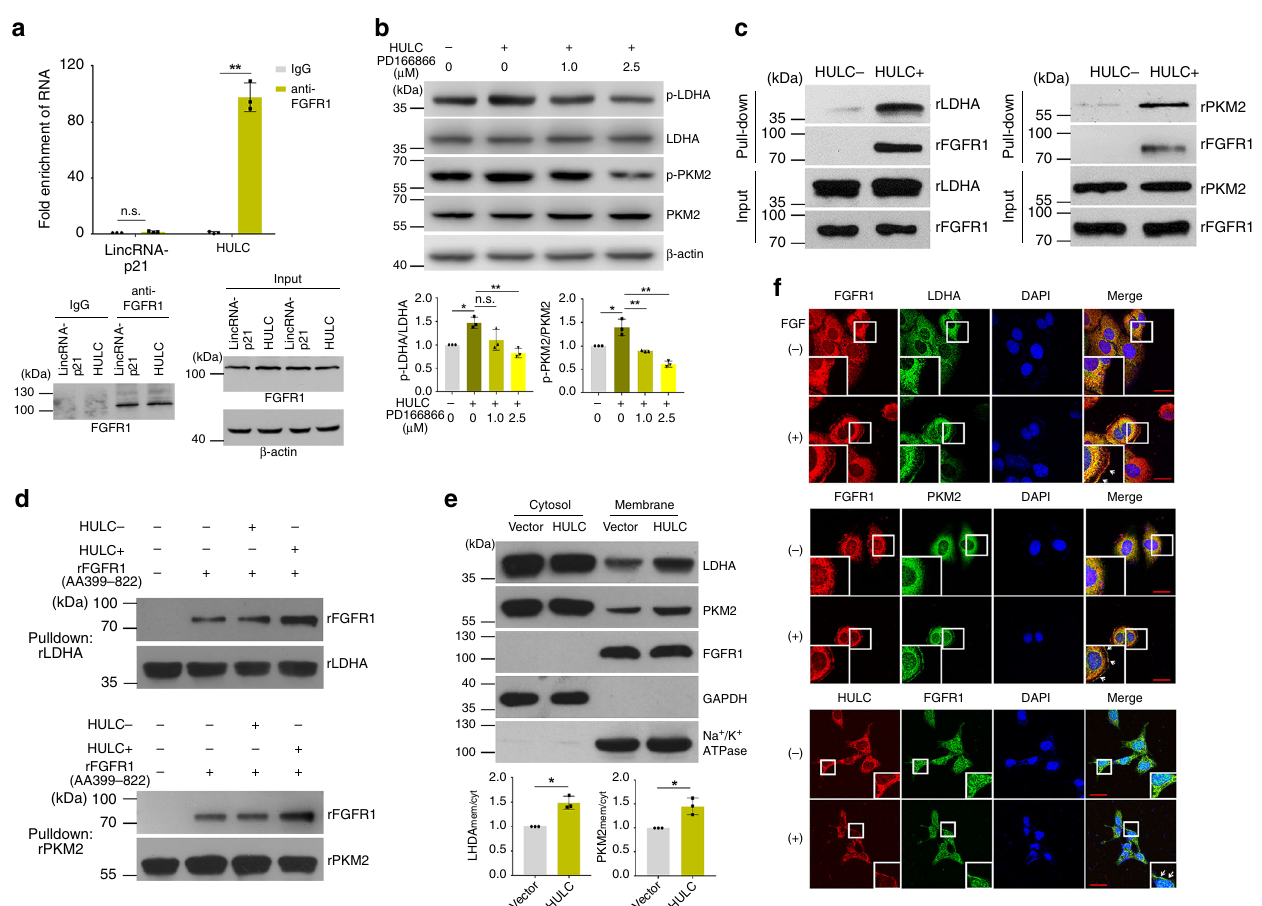
Fig. 5 HULC modulates the phosphorylation of LDHA and PKM2 through FGFR1. a qRT-PCR analysis of the enrichment of HULC in FGFR1 immunoprecipitates. LincRNA-p21 was used as the RNA control. Data represent mean ± s.d. of triplicate independent analyses (*** P < 0.001, n.s., not signi fi cant, by two-sided Student ’ s t test). Immunoblots of FGFR1 in the cell lysates and immunoprecipitates are shown in the lower panel. b Immunoblots of p-LDHA (Y 10 ), LDHA, p-PKM2 (Y 105 ), and PKM2 in the cell lysates. HepG2 cells overexpressing HULC were incubated with the indicated concentrations of FGFR1 inhibitor PD166866 for 24 h. DMSO was added instead in the control groups. Band intensities were measured by ImageJ. Data represent mean ± s.d. of triplicate independent experiments. c In vitro transcribed biotinylated HULC was incubated with rFGFR1 and rLDHA (left panel) or rPKM2 (right panel) at 4 °C for 3 h, and the RNA-protein complexes were isolated with streptavidin-conjugated beads. Levels of rLDHA or rPKM2 in the pull down were examined by western blotting. Biotinylated antisense HULC was used as control. d His-tag pull-down assay results showing that HULC enhances the binding between FGFR1 and the two glycolytic enzymes. His-tagged rLDHA (upper panel) or rPKM2 (lower panel) was incubated with Dynabeads ® His-tag isolation magnetic beads at 4 °C for 4 h. Next, the beads were isolated and then incubated with in vitro transcribed HULC or antisense HULC, followed by the addition of rFGFR1 (AA399-822). Finally, the beads were isolated, and rLDHA and rFGFR1 in the pull down were examined by western blotting. e Immunoblots of LDHA, PKM2, and FGFR1 in the cytosol and membrane fractions. GAPDH was examined as the cytosol marker, and Na + /K + ATPase was used as the membrane marker. Band intensities were measured by ImageJ. Data represent mean ± s.d. of triplicate independent experiments (* P < 0.05, by two-sided Student ’ s t test). f Representative micrographs of FGFR1, LDHA, PKM2, and HULC in cells treated with or without 10 ng mL − 1 FGF. Cell nuclei were stained with DAPI, and the scale bar was 20 μ m. See also Supplementary Fig. 5. Source data are provided as a Source data fi